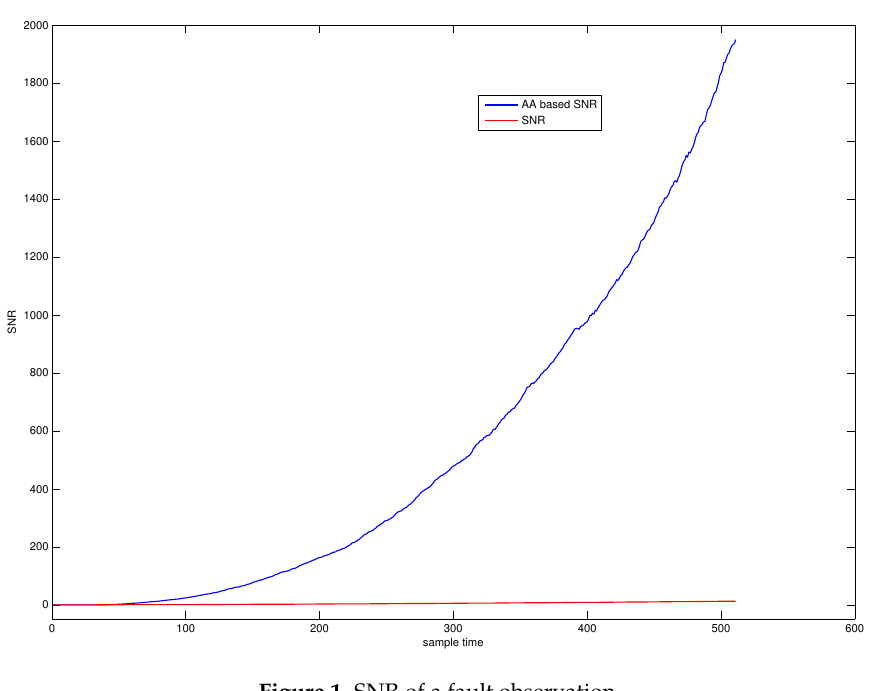
Figure 1. SNR of a fault